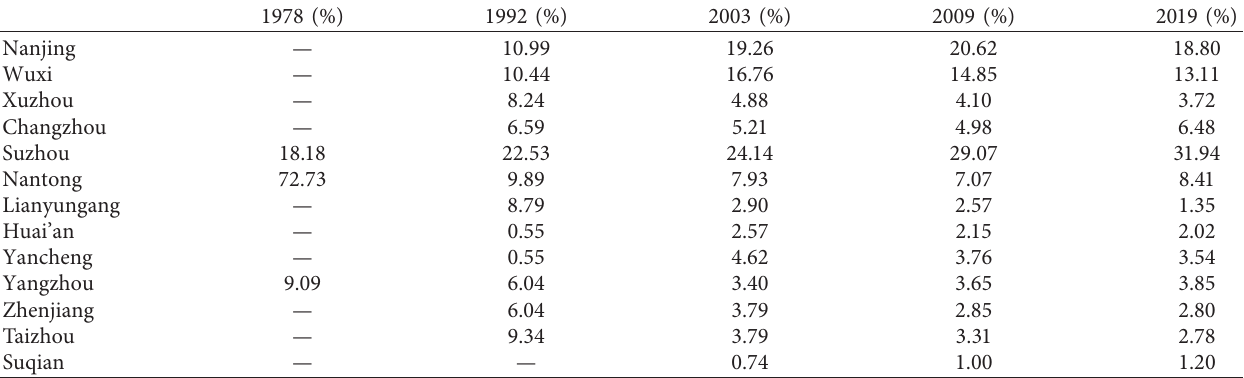
Table 2: Proportion of headquarters-branch enterprise linkages in cities in Jiangsu Province.